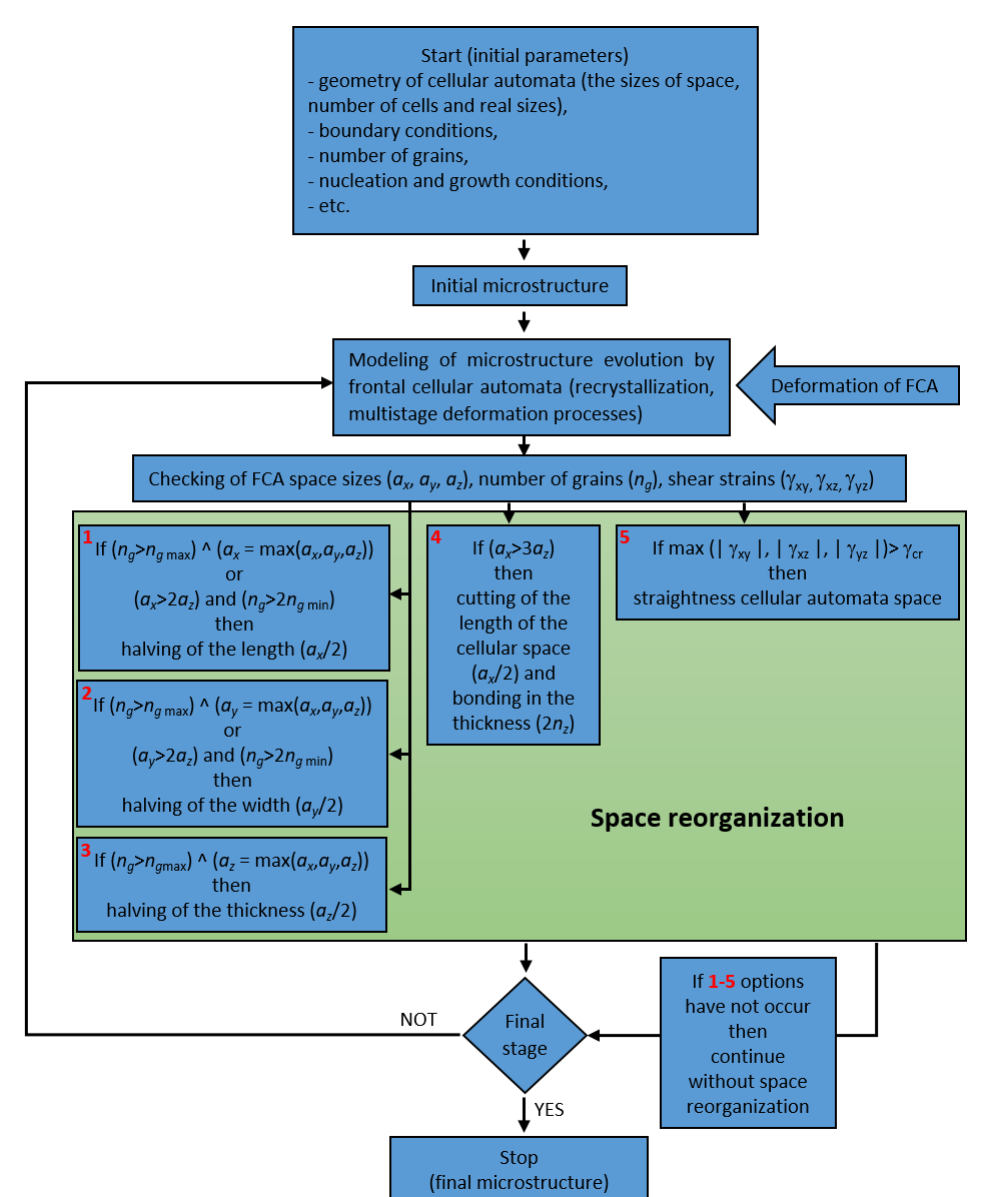
Figure 17. Block diagram of automatic selection of the space reorganization method.